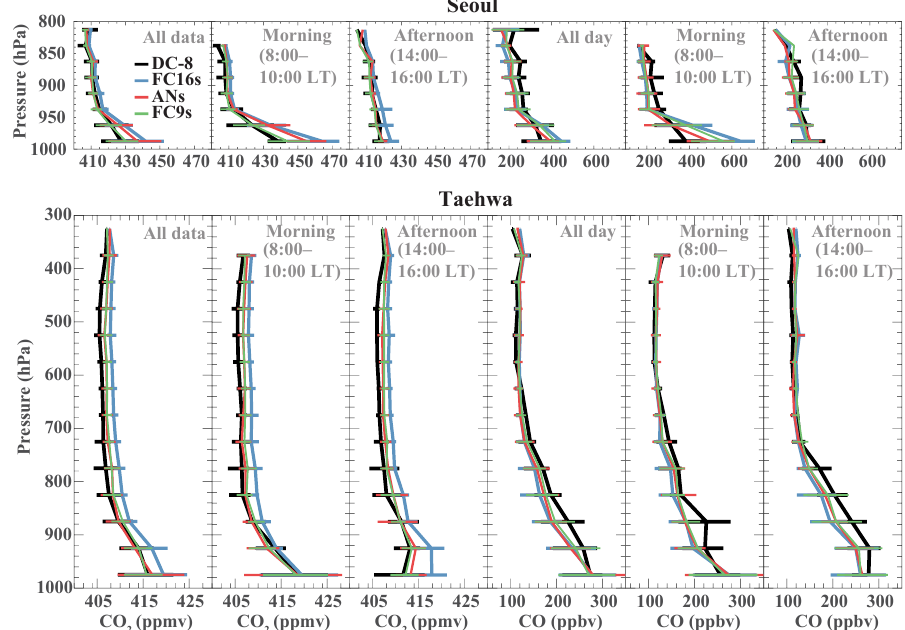
Figure 5. Temporal variation of averaged vertical profiles of CO 2 and CO mixing ratios from the DC-8 aircraft data and CAMS over the Seoul and Taehwa flight groups. The first, second, and third columns are averaged CO 2 profiles for all day, morning (08:00–10:00LT), and afternoon (14:00–16:00LT), respectively. Horizontal bars correspond to interquartile ranges (between 25th and 75th percentiles) of the profiles. The fourth, fifth, and sixth columns are the same as the first three columns but for